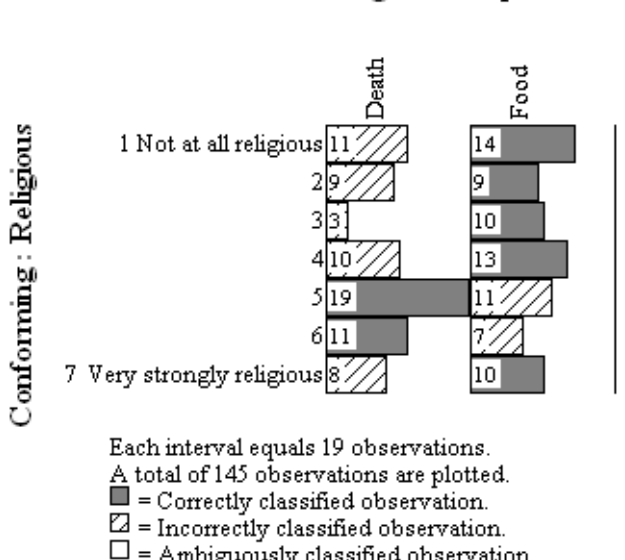
Figure 12. Multigram of actual observations for Terror Management Theory